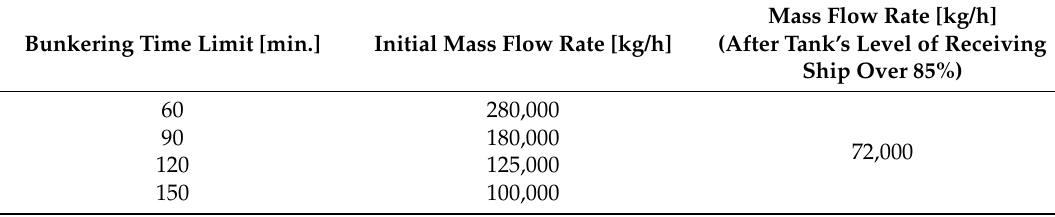
Table 2. LNG mass flow rates during different bunkering time